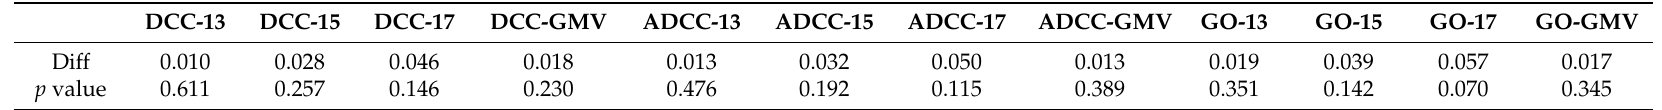
Table 5. Comparison of Sharpe Ratios.